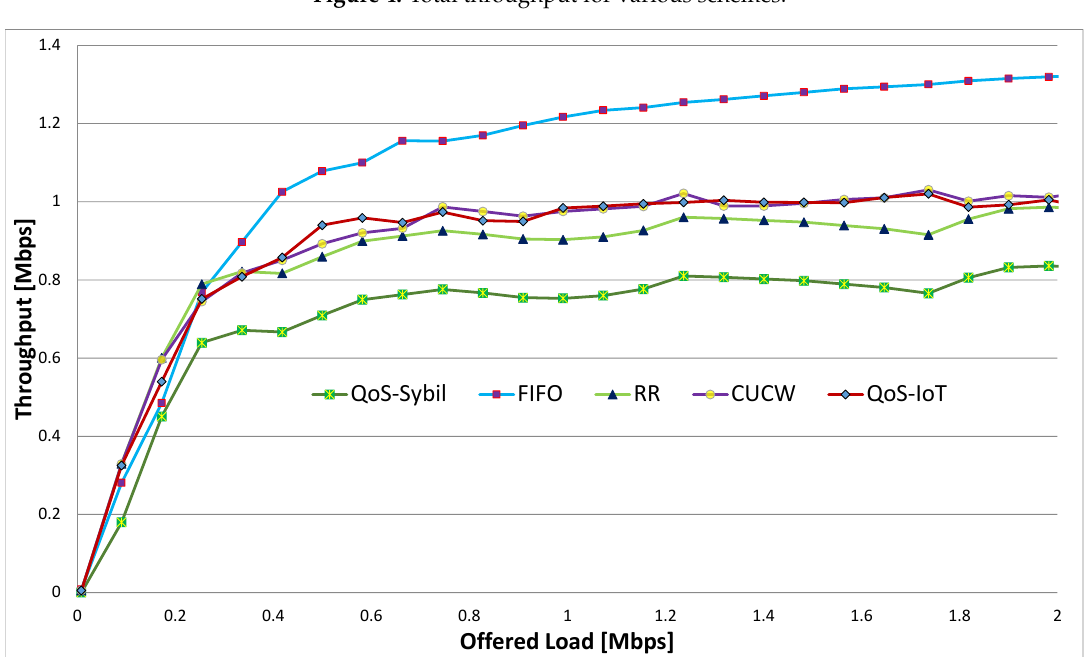
Figure 4. Total throughput for various schemes.